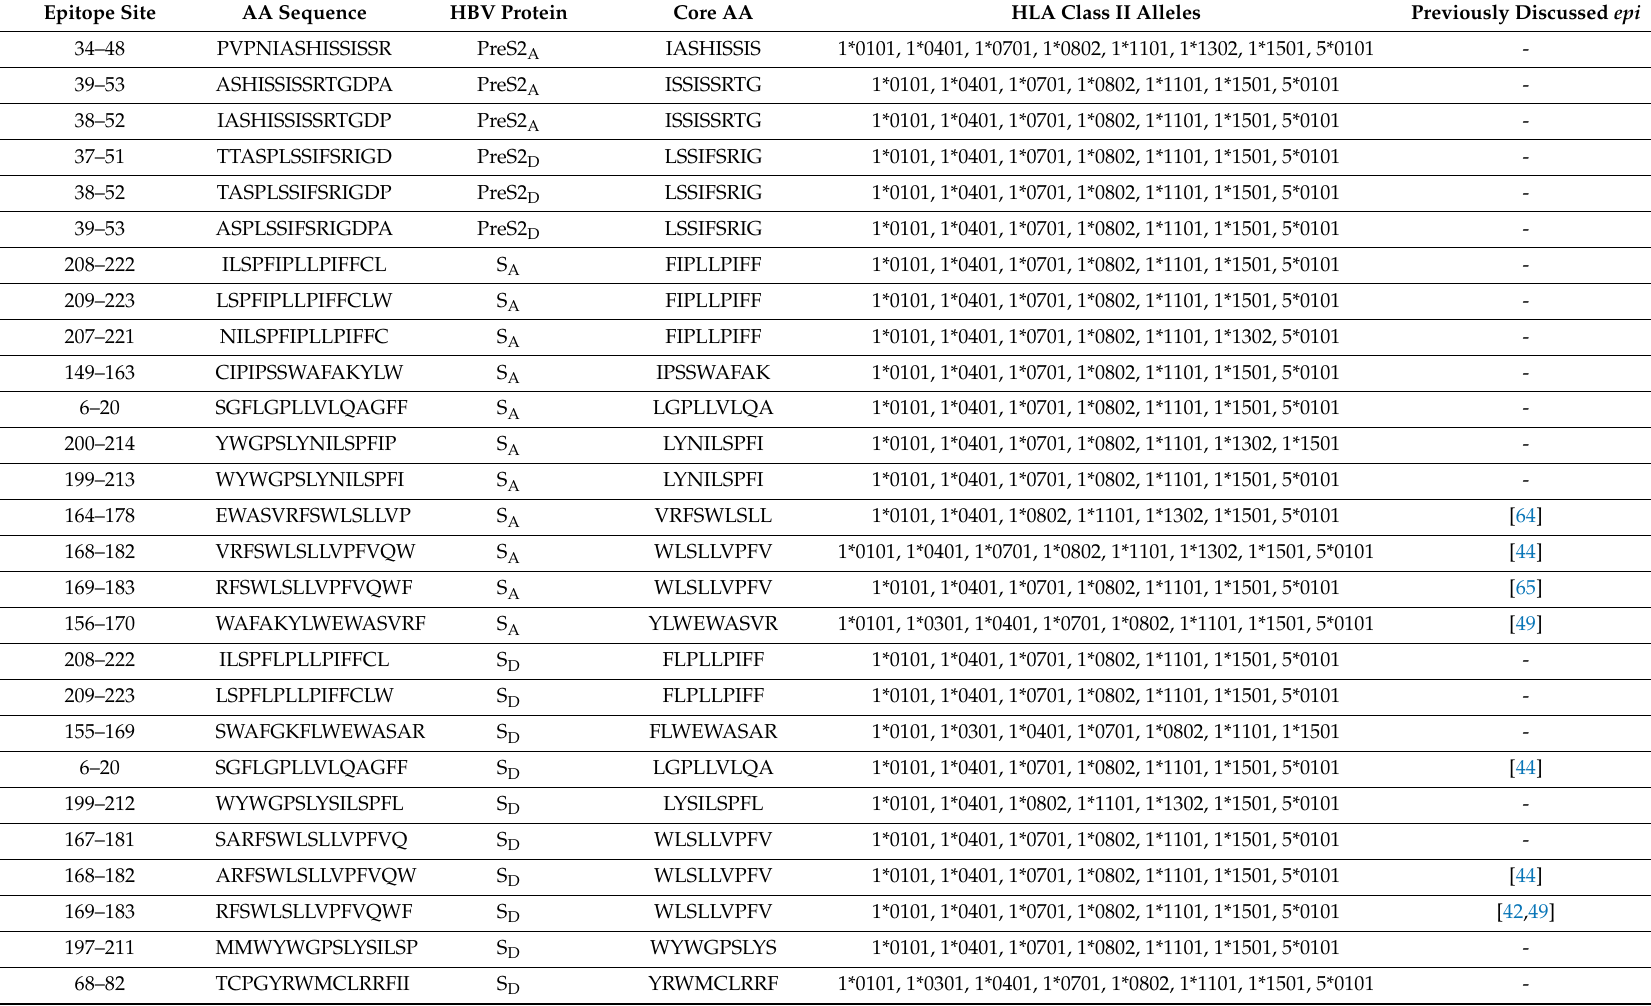
Table 4. Highlighting most promiscuous T cell epitopes restricted to 9 HLA class II